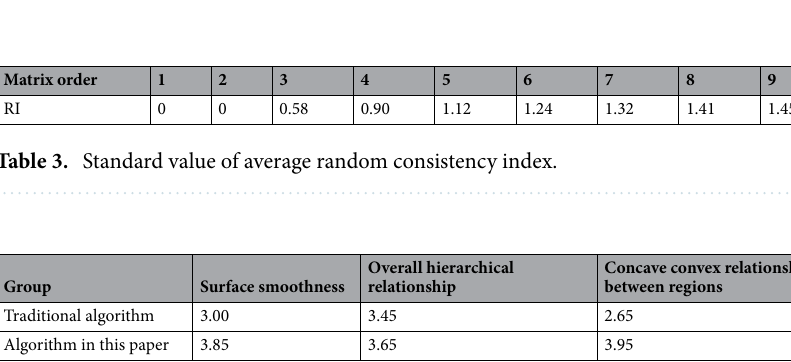
Table 2. Comparison matrix of evaluation indicators for bas-relief effect.